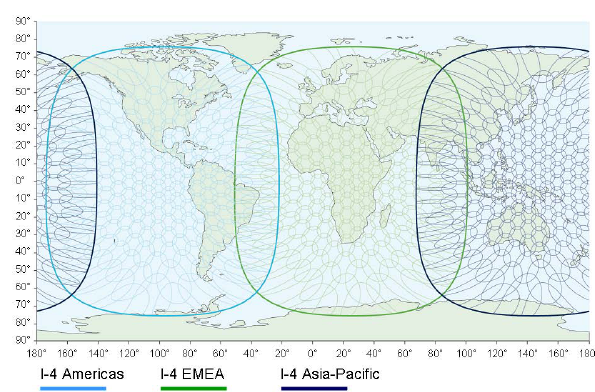
Fig. 11. Coverage areas of Inmarsat’s three geostationary satellites and their individual spot beams. Indonesia and the part of the In- dian Ocean relevant for the GTEWS project, lie well within the area covered by I-4 Asia